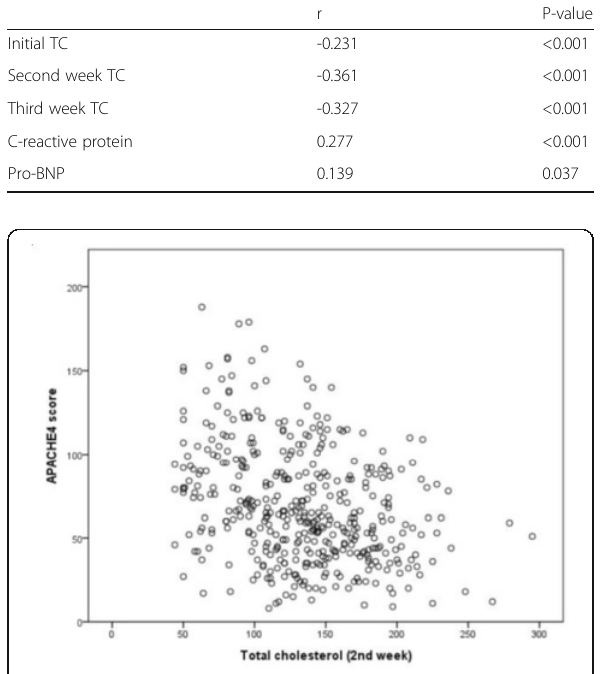
Fig. 102 (abstract A249). The second week TC and APACHE4 score